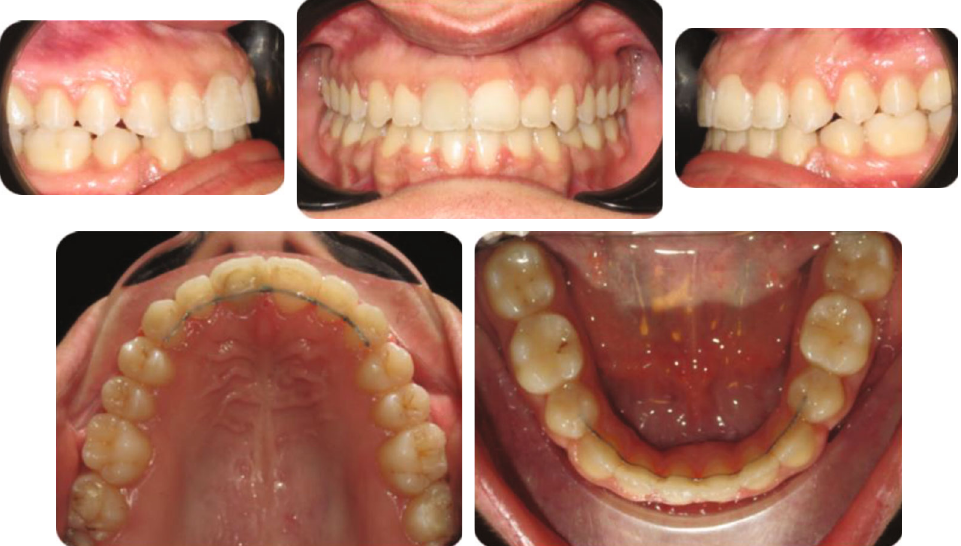
Figure 6: Posttreatment intraoral photographs.